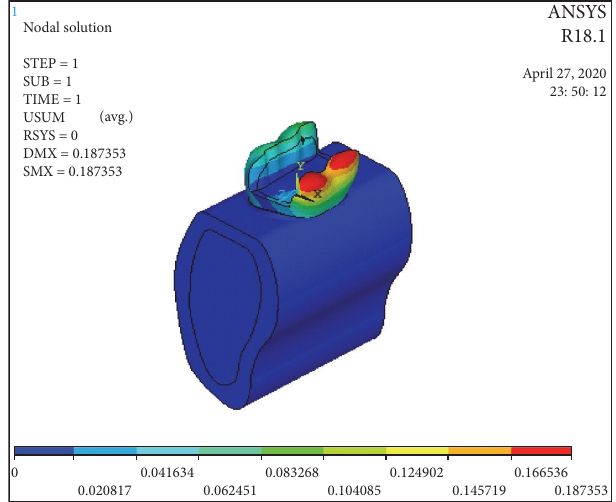
F IGURE 6: Stress analysis of mesio-occlusal-distal cavity in mandib- ular molar shows the concentration of stress on the functional cusp. The maximum stress is on both the functional cusps. The magni- tude of stress was more as compared to the intact